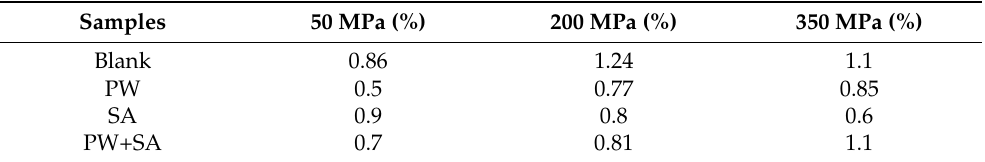
Table 2. Percentage of area porosity of sintered Cu–15Fe powder compacts with varying lubricant types under different pressures.